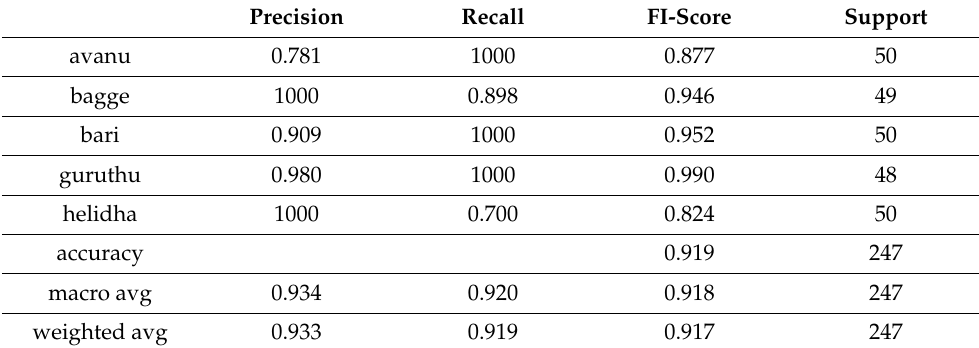
Table 4. Report on metrics for the Kannada database.